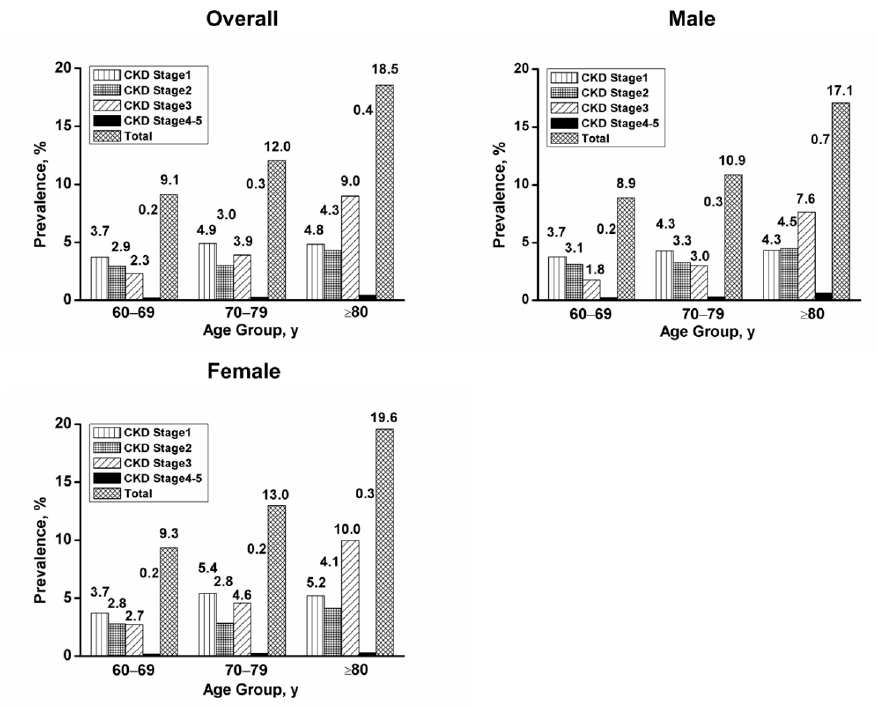
Figure 2. Prevalence of chronic kidney disease in di ff erent age groups. CKD—chronic kidney disease.